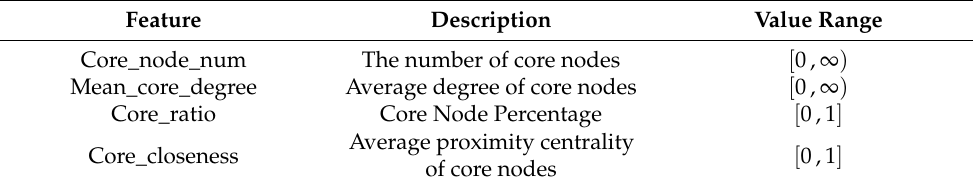
Table 1. Core Node